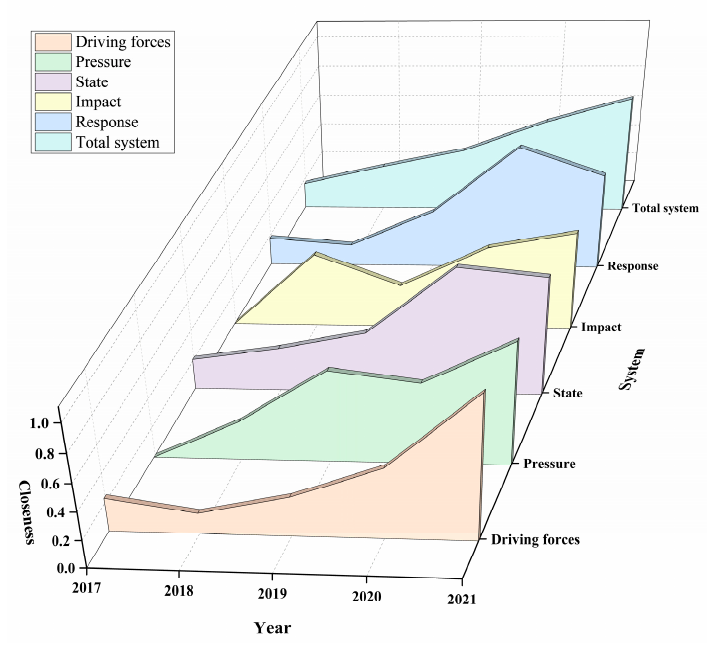
Figure 5. Change Trend of Closeness in 2017–2021.